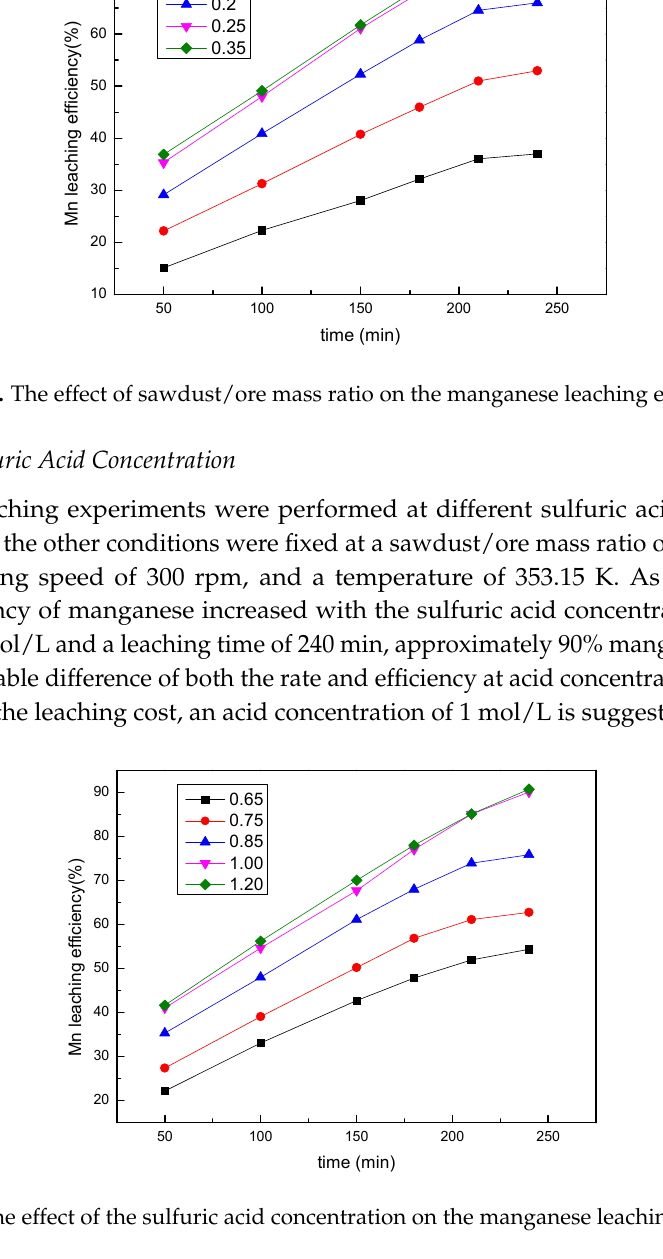
liquid/solid ratio Figure 3. The effect of the liquid/solid ratio on the manganese leaching efficiency. 3.3. Effect of the Sawdust/Ore Mass Ratio The effects of the sawdust/ore mass ratio on the leaching efficiency of manganese were examined by varying the sawdust/ore mass ratio from 0.05 to 0.35, and other conditions were fixed at a sulfuric acid concentration of 0.85 mol/L, a liquid/solid ratio of 8:1, a stirring speed of 300 rpm,